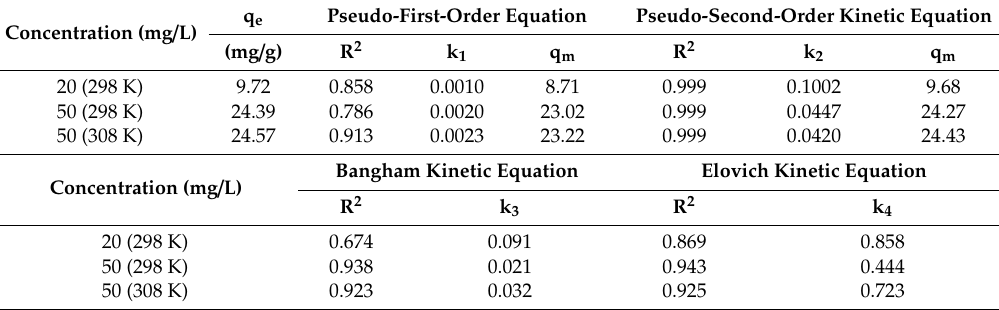
Figure 4. Adsorption kinetics of Cr(VI) adsorption on FM-MBC. ( a ) Pseudo-first-order, ( b ) Pseudo-second-order, ( c ) Banghamkinetic, ( d ) Elovich kinetic. Table 1. Kinetic parameters for Cr(VI) adsorption onto the FM-MBC.